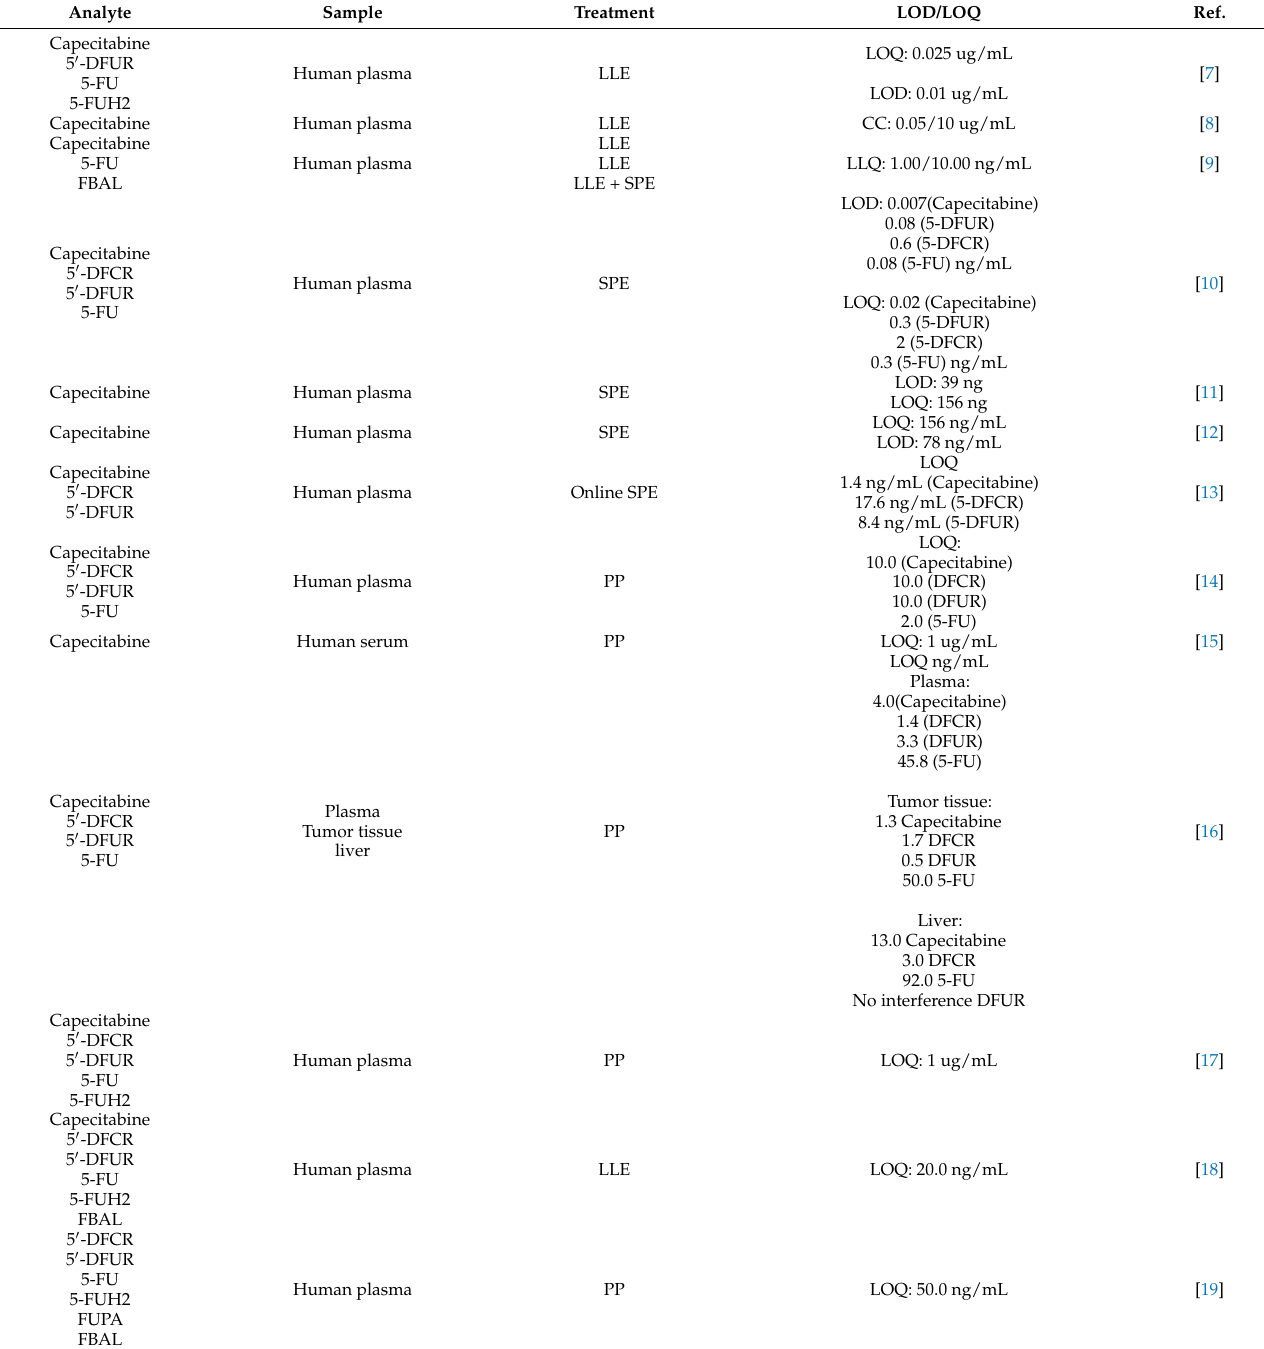
Table 1. Pre-treatment of biological samples for capecitabine and its metabolites.